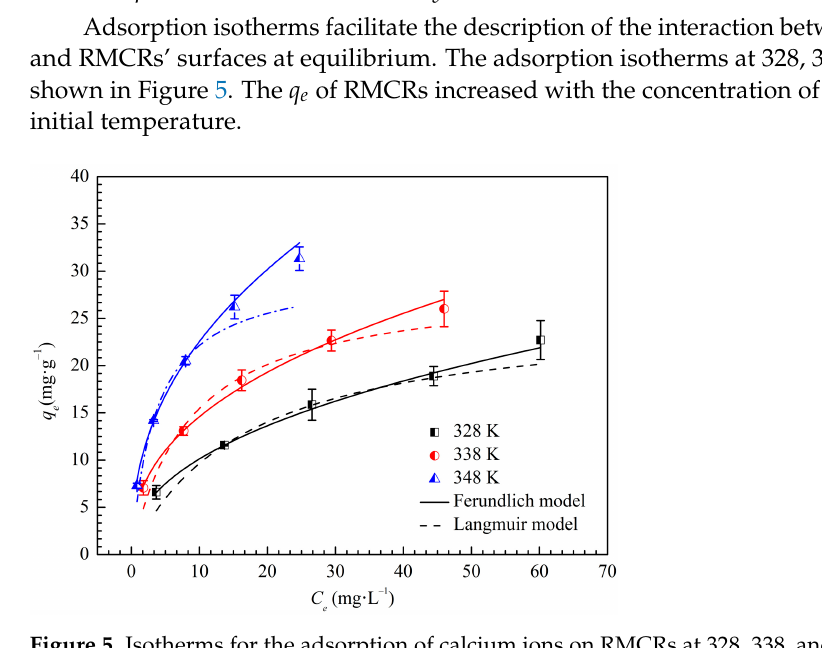
Figure 5. Isotherms for the adsorption of calcium ions on RMCRs at 328, 338, and 348 K.